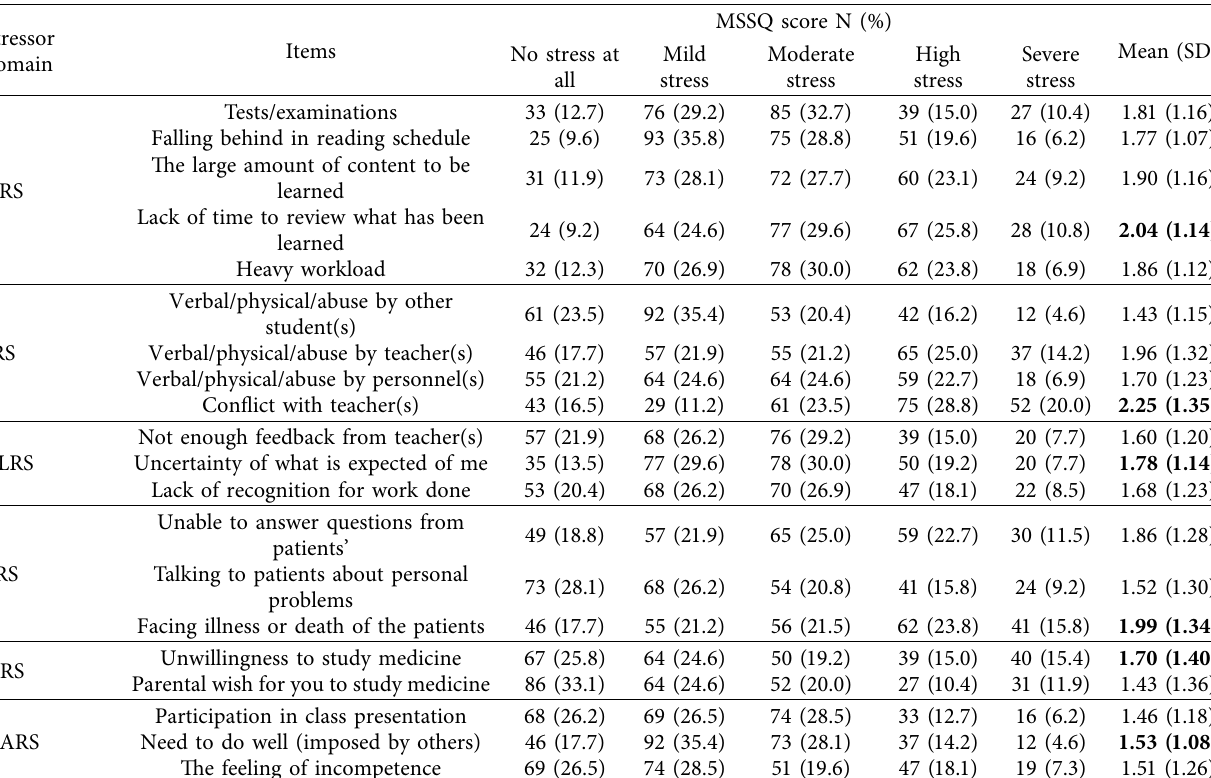
Table 2: Sources of stress among study participants from items of medical student stressors, N � 260, AU, January 2019. Stressor domain